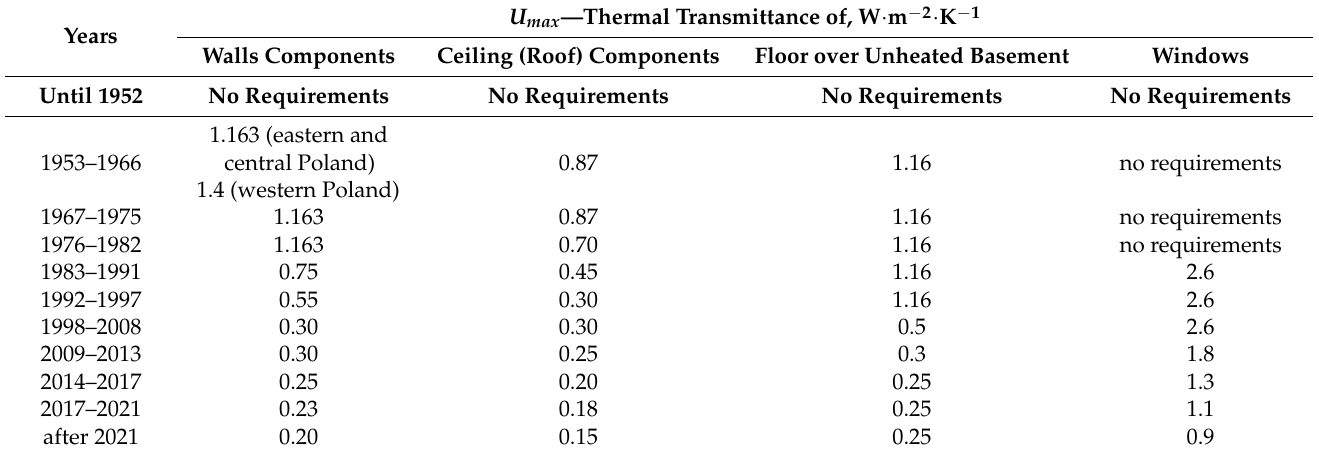
Table 1. Required maximum thermal transmittance value for external walls, storage ceilings (roofs), floor over unheated basement (and on the ground) and